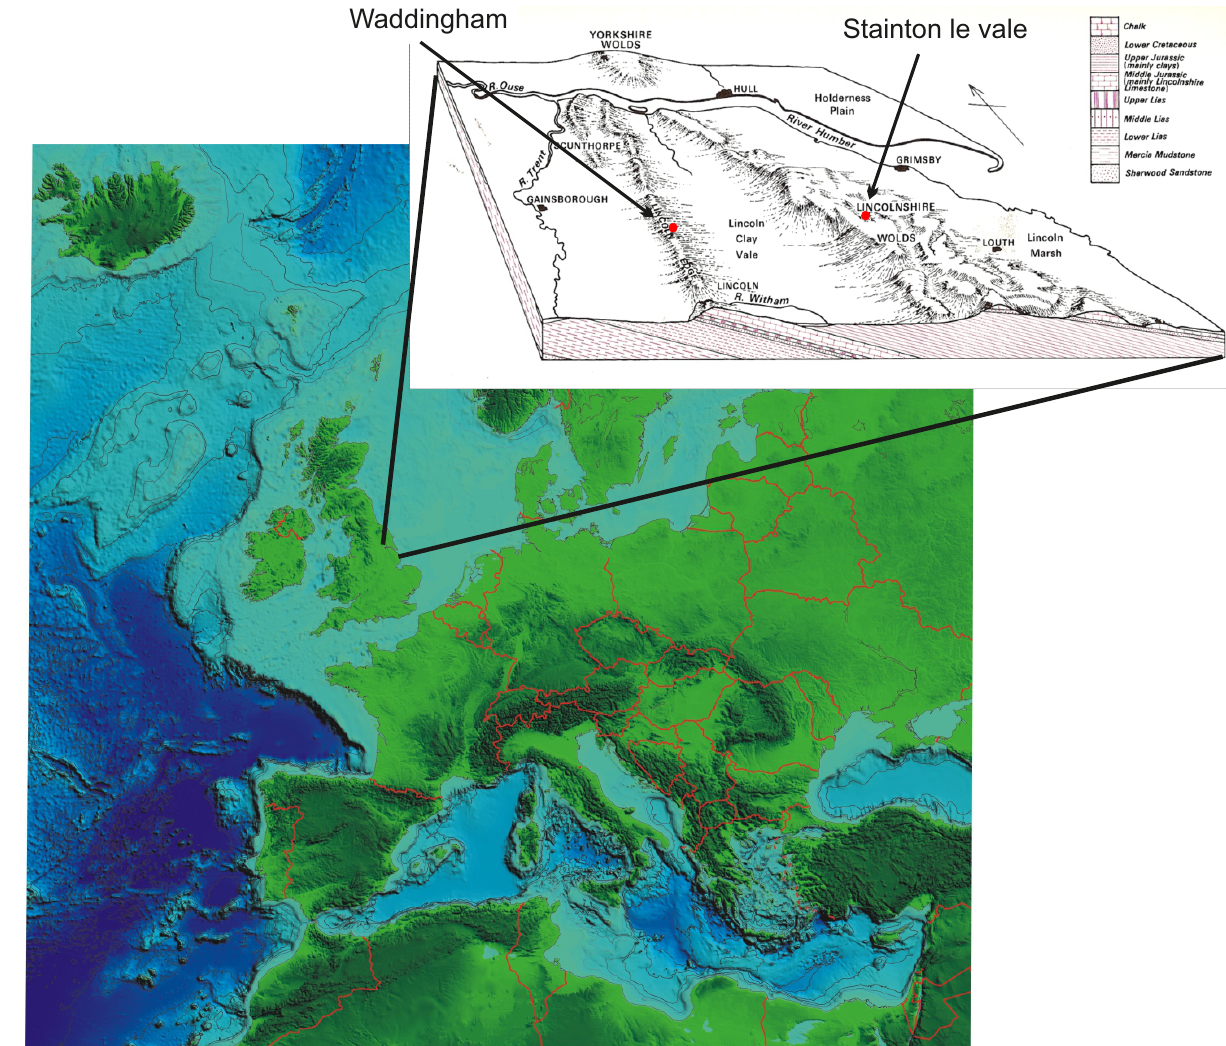
Figure 10. Location of tufa and sub-tufa sites in Lincolnshire, UK. Insert: geological map from Kent et al. (1980).